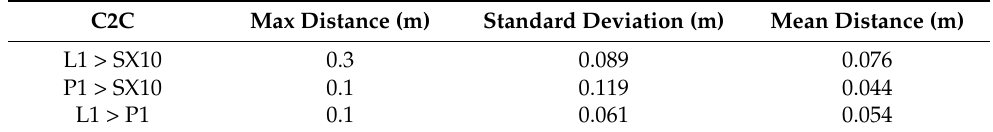
Table 6. C2C distance analysis